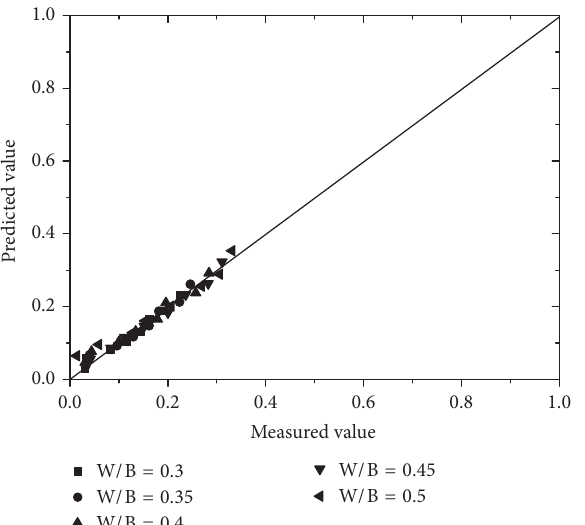
Figure 11: The predicted and measured values of the degree of the fly ash reaction of cement-fly ash pastes.